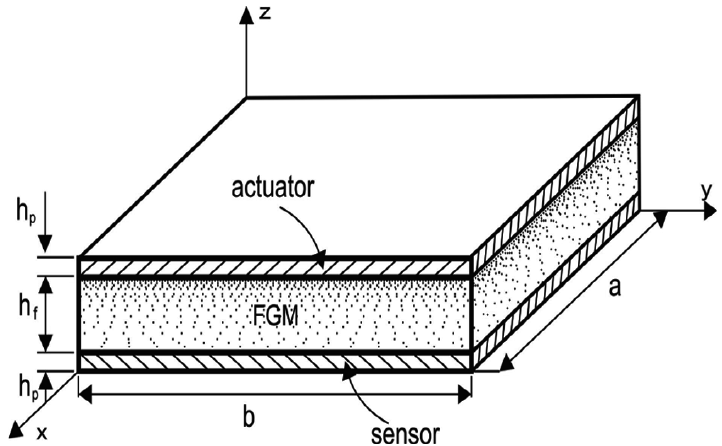
Figure 1. Schematic of sandwich plate.